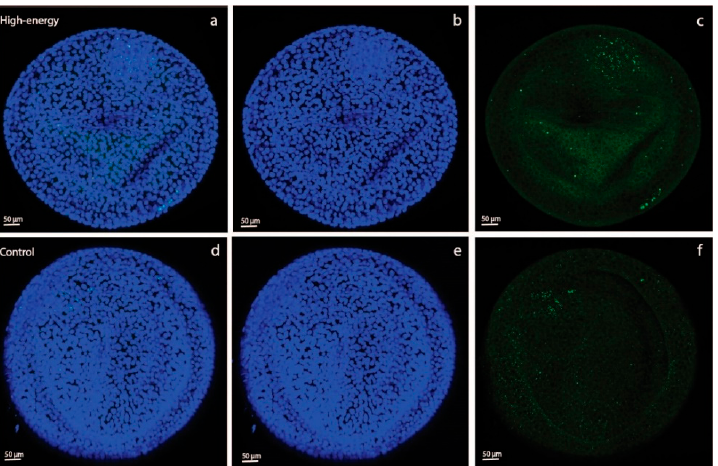
Figure 3. Confocal micrographs of day-7 embryos originating from Shetland pony mares fed a high-energy (200% of net energy requirements; ( a – c )) or control (maintenance; ( d – f )) diet, obtained using a Leica SPE II DMI-4000 confocal microscope (Leica Microsystems, Wetzlar, Germany). Cell nuclei are labeled with 4 (cid:48) ,6-diamidino-2-phenylindole (DAPI; blue fluorescence). Lipid droplets are labeled with BODIPY 493/503 (green fluorescence). ( a , d ): merged micrograph; ( b , e ): blue channel (414–466 nm); ( c , f ): green channel (511–577